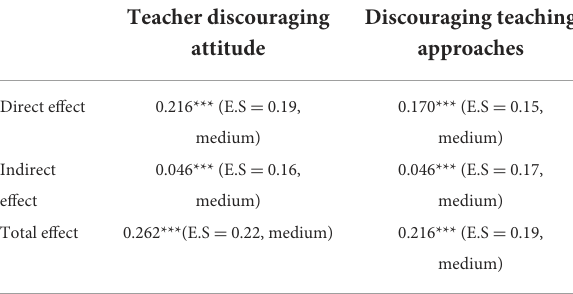
TABLE 7 Direct, indirect, and total